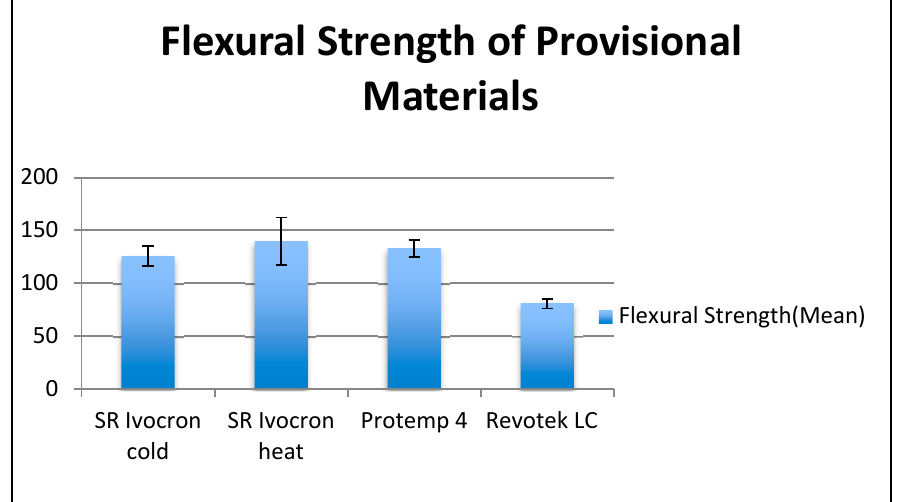
Figure 6. Histogram of mean flexural strength of four tested groups.